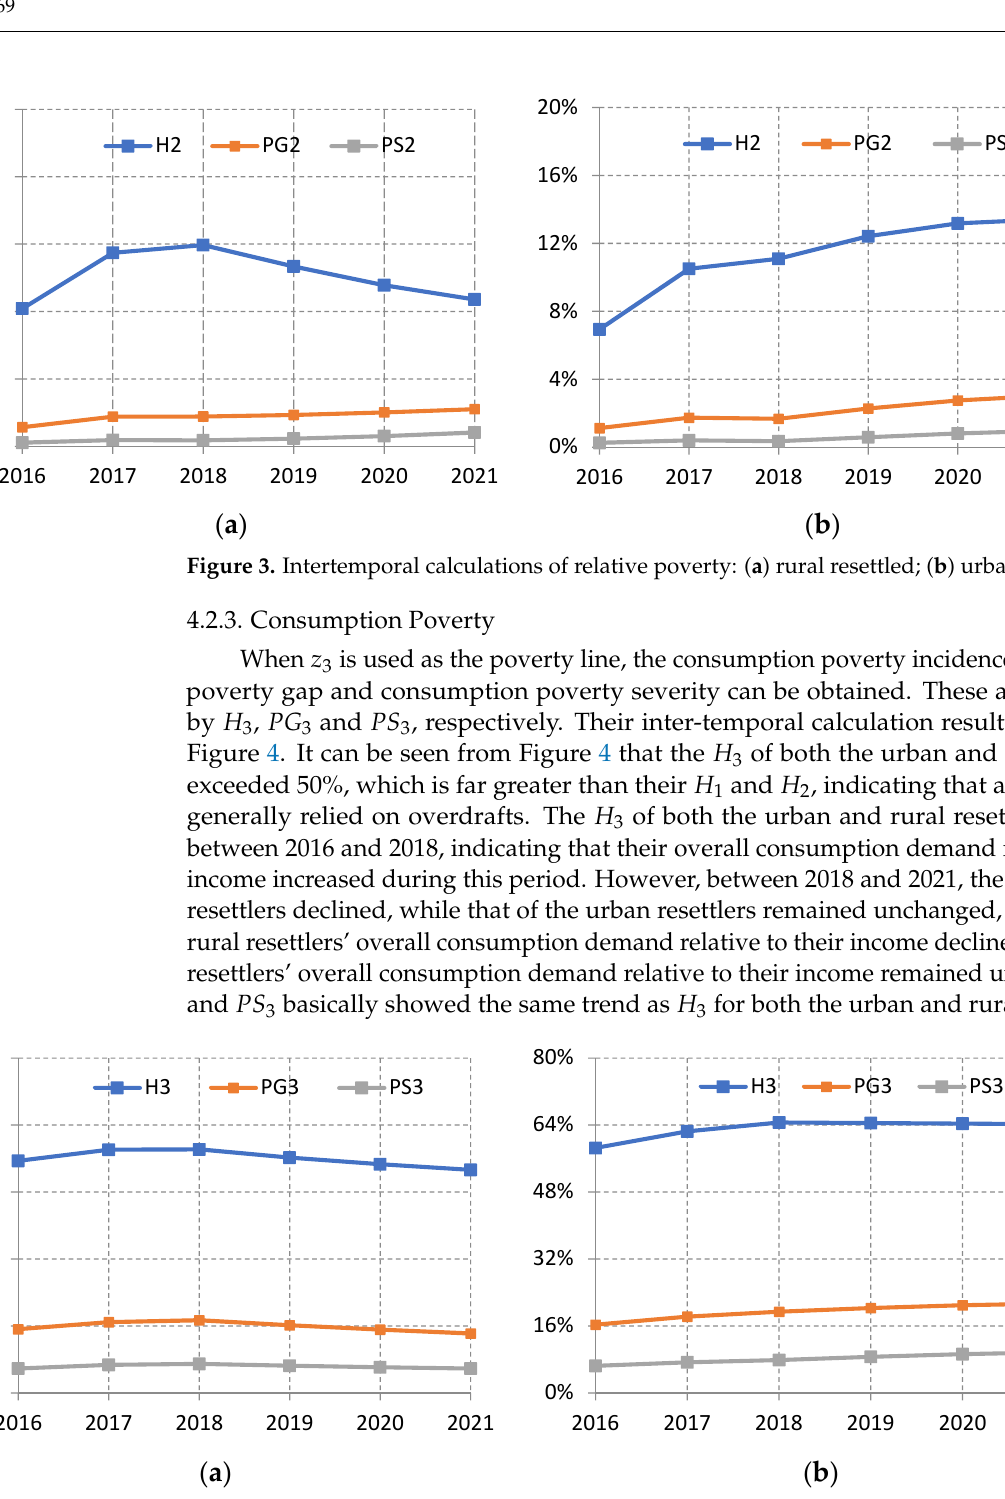
( b ) Figure 2. Intertemporal calculations of absolute poverty: ( a ) rural resettled; ( b ) urban resettled. 4.2.2. Relative Poverty When 𝑧 (cid:2870) is used as the poverty line, the relative poverty incidence, relative poverty gap and relative poverty severity can be obtained. These are represented by 𝐻 (cid:2870) , 𝑃𝐺 (cid:2870) and 𝑃𝑆 (cid:2870) , respectively. Their inter-temporal calculation results are shown in Figure 3. As can